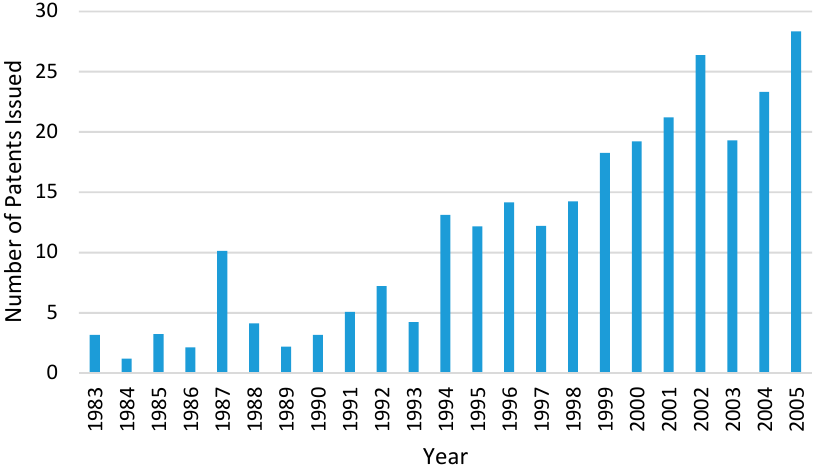
Figure 6. Number of Hot-Melt Extrusion patents issued for pharmaceutical applications between year 1983 to 2006 (the data for chart is extracted from reference [32], Taylor & Francis, 2008).